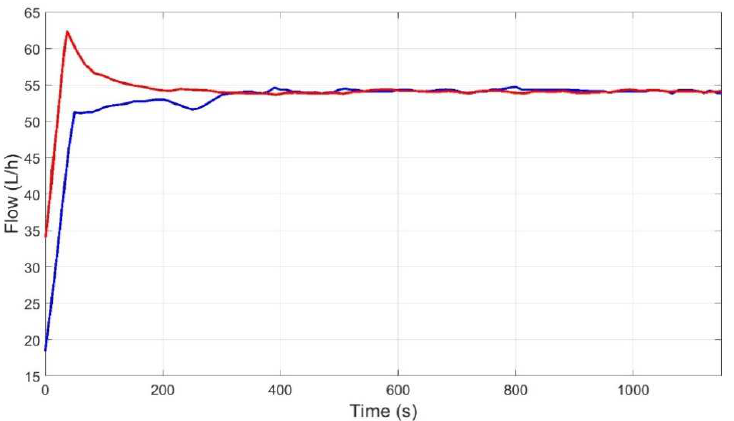
Figure 15. Evolution of pressure output to reach the representative operating point (P_ref = 2 bar, Q r _ref = 54 L/h) using inverse local models (blue), and expert control based on fuzzy logic (red).